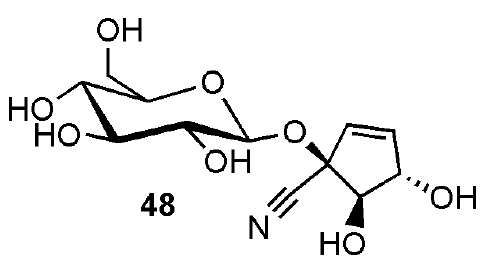
Figure 8. Cyanogenic glycosides group B-1, cyclopentene derivatives with one (compounds 34 – 35 ) or two (compounds 36 – 47 ) hydroxy groups: ( R )-deidaclin ( 34 ), ( S )-tetraphyllin A ( 35 ), (1 R ,4 R )-volkenin ( 36 ), (1 R ,4 R )-volkenin sulfate ( 37 ), (1 R ,4 S )-taraktophyllin ( 38 ), (1 R ,4 S )-6 ′ - O - α - L -rhamnopyranosyl taraktophyllin ( 39 ), (1 S ,4 R )-epivolkenin/passicoriacin ( 40 ), 6 ′ - O - α - L -rhamnopyranosyl epivolkenin ( 41 ), passicapsin ( 42 ) passitrifasciatin ( 43 ), (1 S ,4 R )-passibiflorin ( 44 ), (1 S ,4 S )-tetraphyllin B ( 45 ), (1 S ,4 S )-tetraphyllin B sulfate ( 46 ) and passicoccin ( 47 ). Gynocardin ( 48 ) (Figure 9), the so far only cyclopentene derivative featuring three hy- droxy moieties in the cyclopentene part of the molecule, was isolated from Gynocardia odorata R.Br. (Achariaceae) [37].